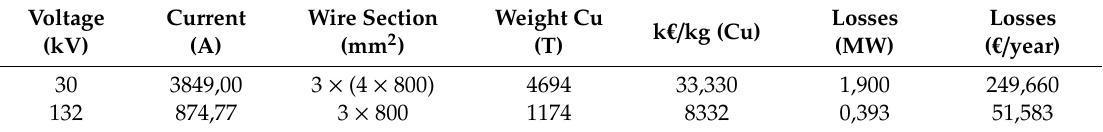
Figure 12. Scheme of generation and transport of energy from o ff shore wind farms. Table 2. Example of power and economic losses as a function of the grounding voltage (50 €